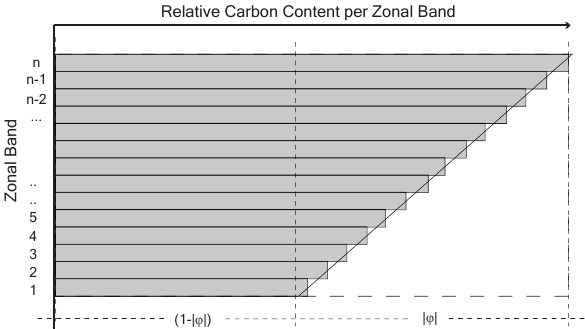
Fig. A1. Illustration of the simplified parameterisation to vary the north-south distribution of the initial carbon content C 0 across the n zonal bands with the parameter ϕ , here shown for a “northward” bias ( − 1 < ϕ < 0). By default ( ϕ = 0), each zonal band is allocated the same share, 1/n C 0